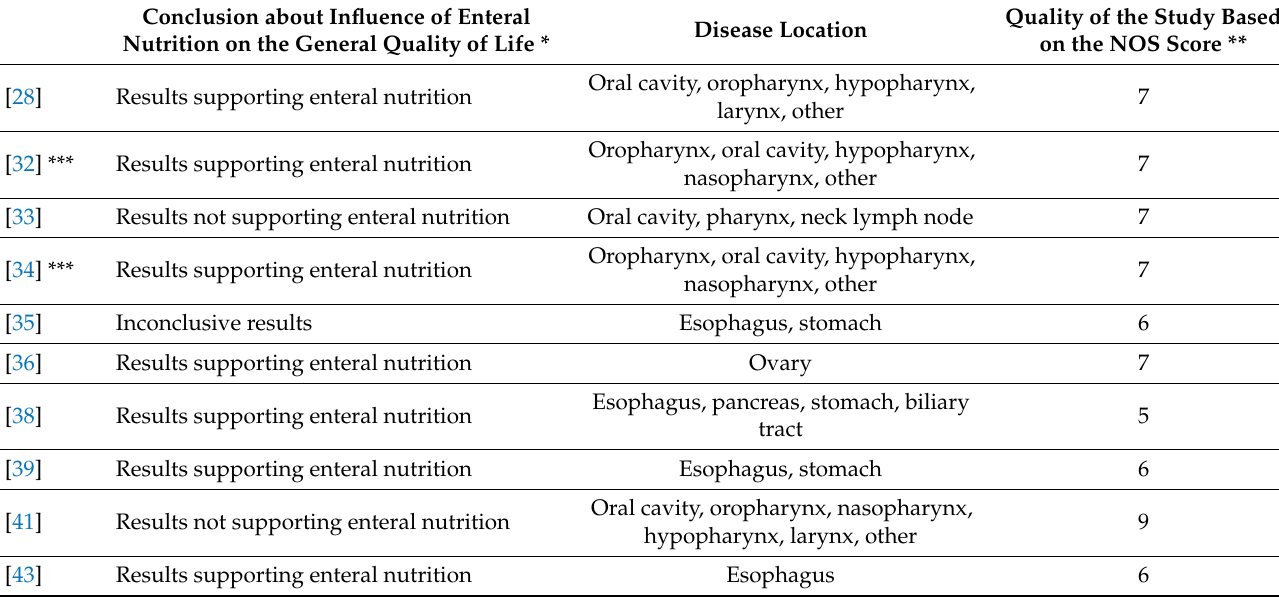
Table 8. The summary of conclusions from the studies comparing patients treated with and without enteral nutrition included to the systematic review accompanied by the Newcastle–Ottawa Scale (NOS) score.